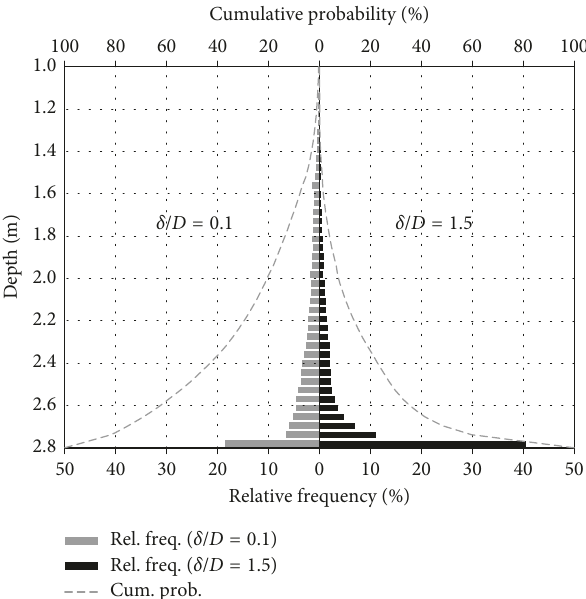
Figure 14: Histograms for the frequency of the critical depth and the cumulative failure probability along with the depth ( T r � 100 years and 18 hours rainfall duration).